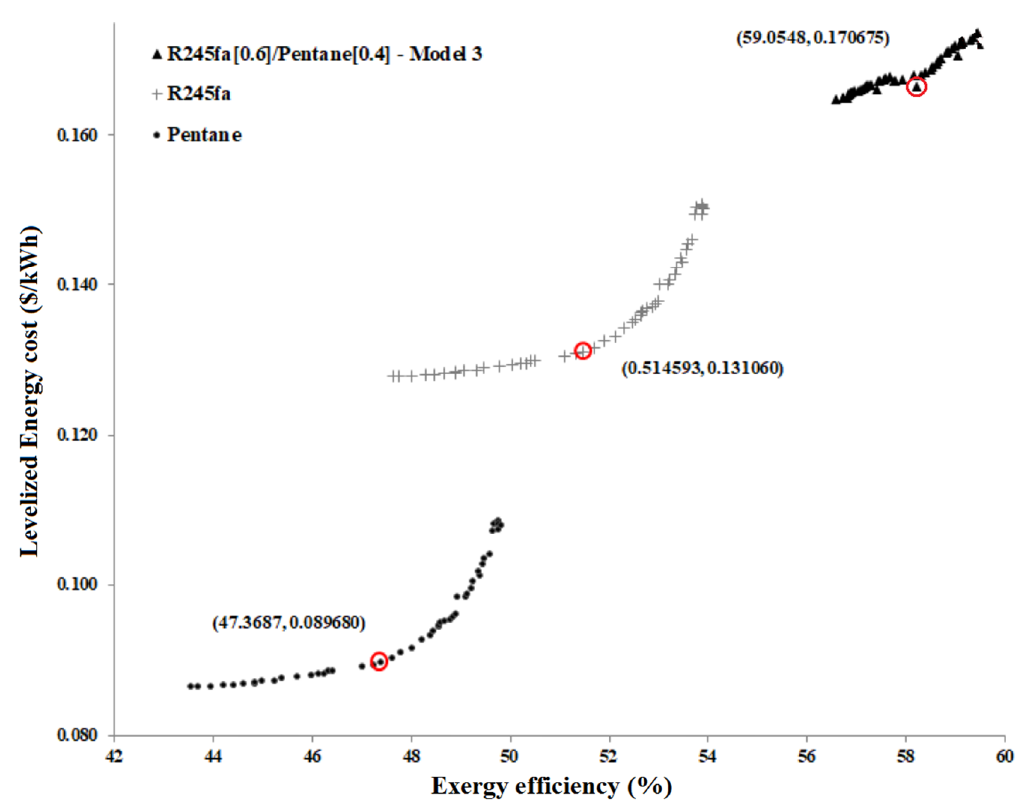
Figure 8. The Pareto frontier solutions in the objective space for model 3 with three di ff erent working Figure 8. the Pareto frontier solutions in the objective space for model 3 with three different working fluids, pure Pentane, pure R24fa and the combined Pentane [0.6] / R24fa [0.4]. fluids, pure Pentane, pure R24fa and the combined Pentane[0.6]/R24fa[0.4].